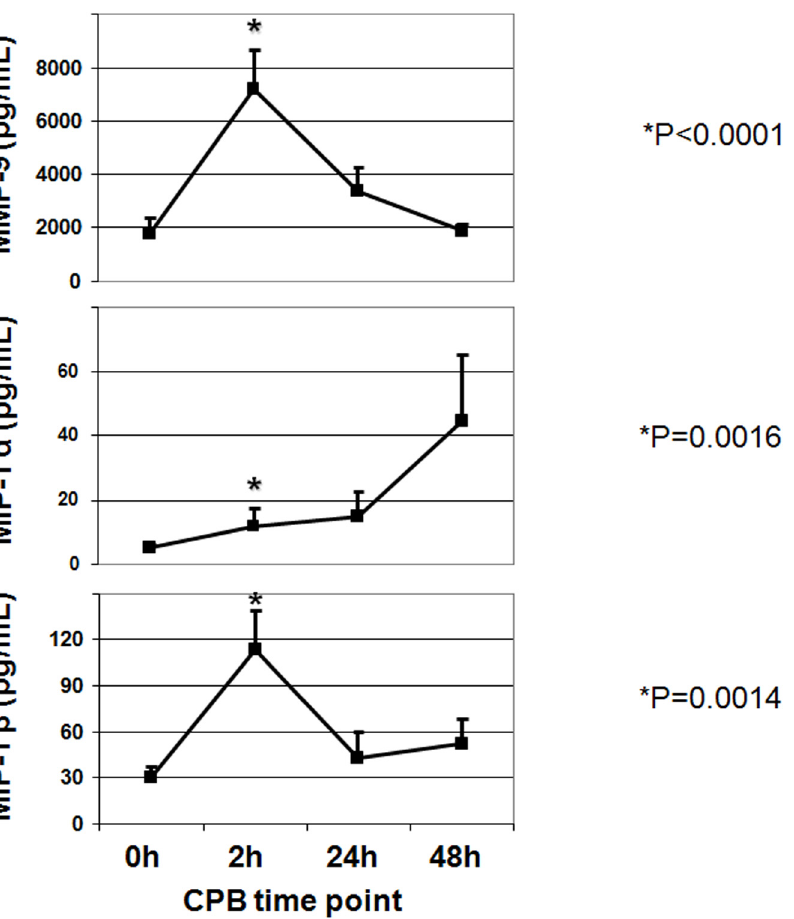
Figure 5. Plasma protein level confirmation. Plasma protein levels (pg/mL) of three CS/CPB –induced genes identified by genome -wide expression profiling. Protein analysis confirmed the whole blood transcriptomics data. We found a time dependent upregulation of matrix metalloproteinase-9 (MMP9) and macrophage inflammatory protein-1 a and b (MIP1a/b) after CS/CPB in an independent cohort of additional 34 patients undergoing on-pump cardiac surgery. Mean (standard error of the mean). * P values; Kruskal-Wallis test for change over time.